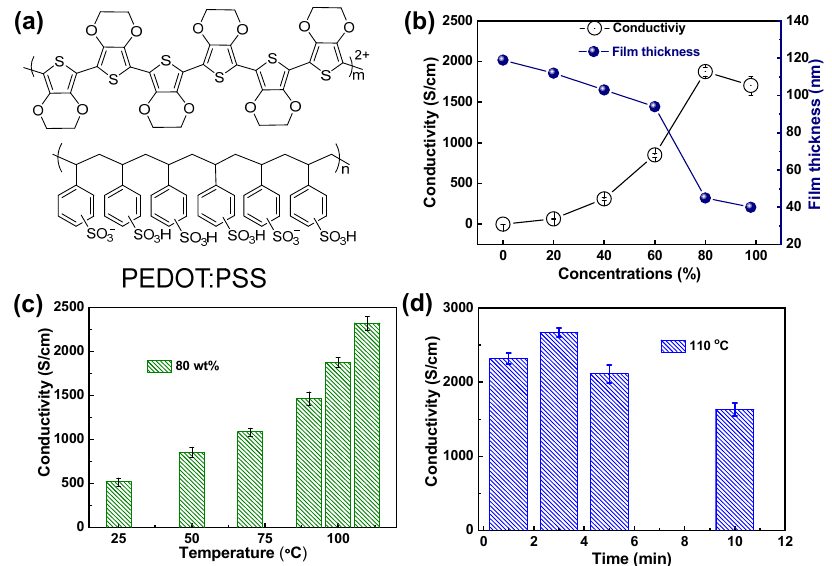
Figure 1. ( a ) Molecular structures of PEDOT and PSS, ( b ) The conductivity variation of PEDOT:PSS films treated with different concentrations H 2 SO 4 (0 wt%, 20 wt%, 40 wt%, 60 wt%, 80 wt%, 98 wt%), ( c ) Temperature-dependent conductivity of PEDOT:PSS films treated with 80 wt% H 2 SO 4 for 1 min, ( d ) Conductivity optimization of PEDOT:PSS films treated with 80 wt% H 2 SO 4 under different treating